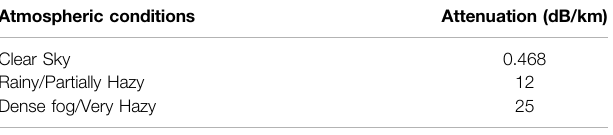
TABLE 1 | Various atmospheric conditions and their parametric values.